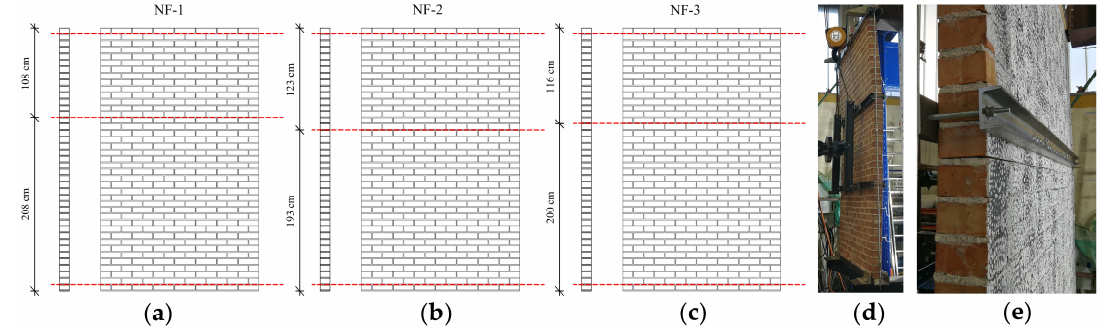
Figure 5. Crack development locations (red dashed lines) of as-built specimens ( a ) NF-1, ( b ) NF-2, and ( c ) NF-3; ( d ) deformation shape of NF-1 and ( e ) mid-height crack opening of specimen